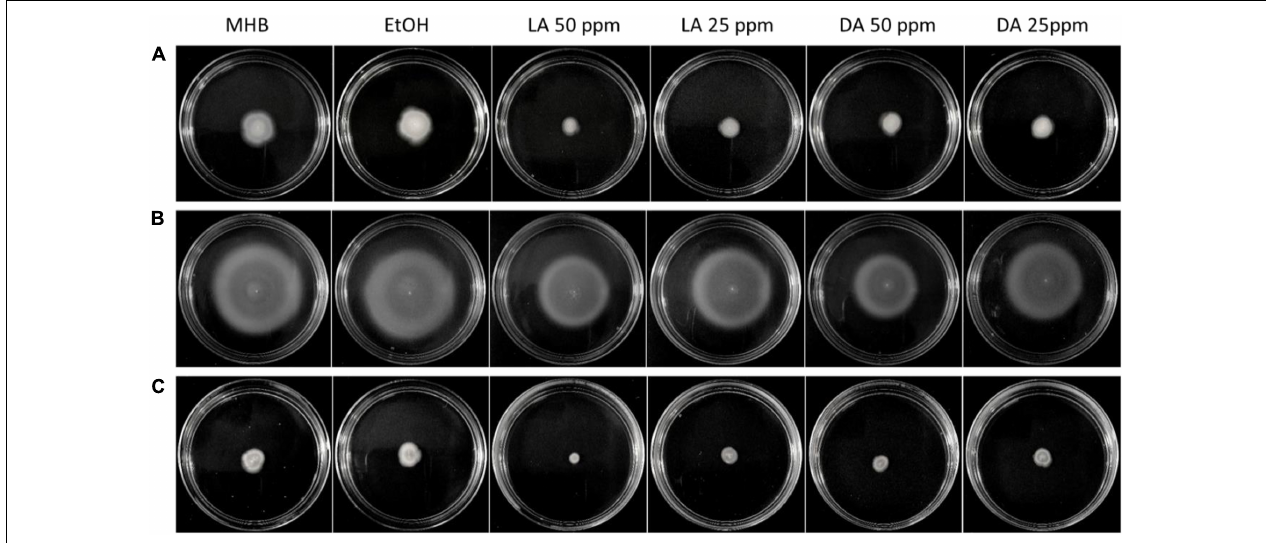
FIGURE 5 | Inhibition of C. jejuni cell motility by lauric acid (L.A.) and decanoic acid (DA). Swarming of C. jejuni F38011 (A) , NCTC11168 (B) , and ATCC33560 (C) in soft agar (MHB + 0.4% agar) was recorded in the absence and presence of specific concentrations of fatty acids after 72 h incubation at 37 ◦ C in a microaerobic condition. Soft agar containing 0.5% EtOH is served as the negative